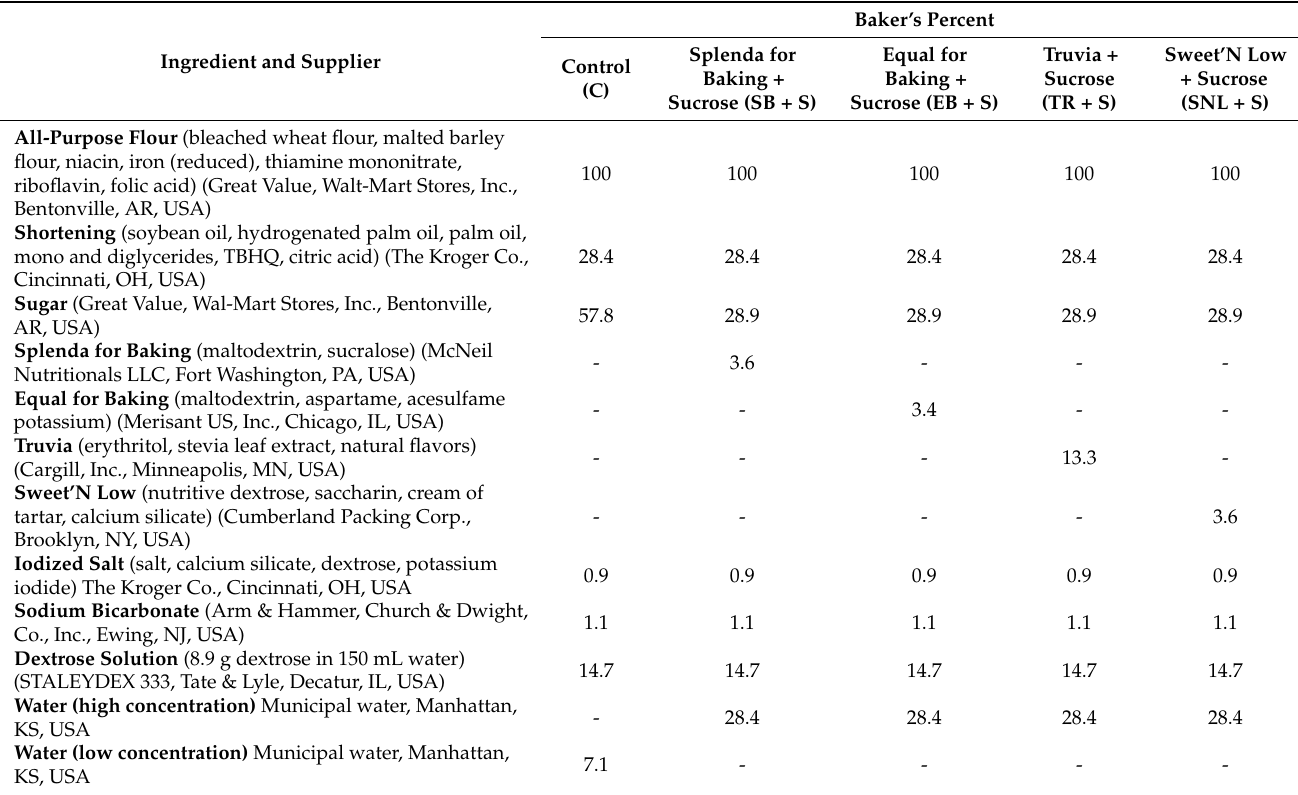
Table 2. Formulation of cookies with 1:1 sucrose to sweetener based on relative sweetness